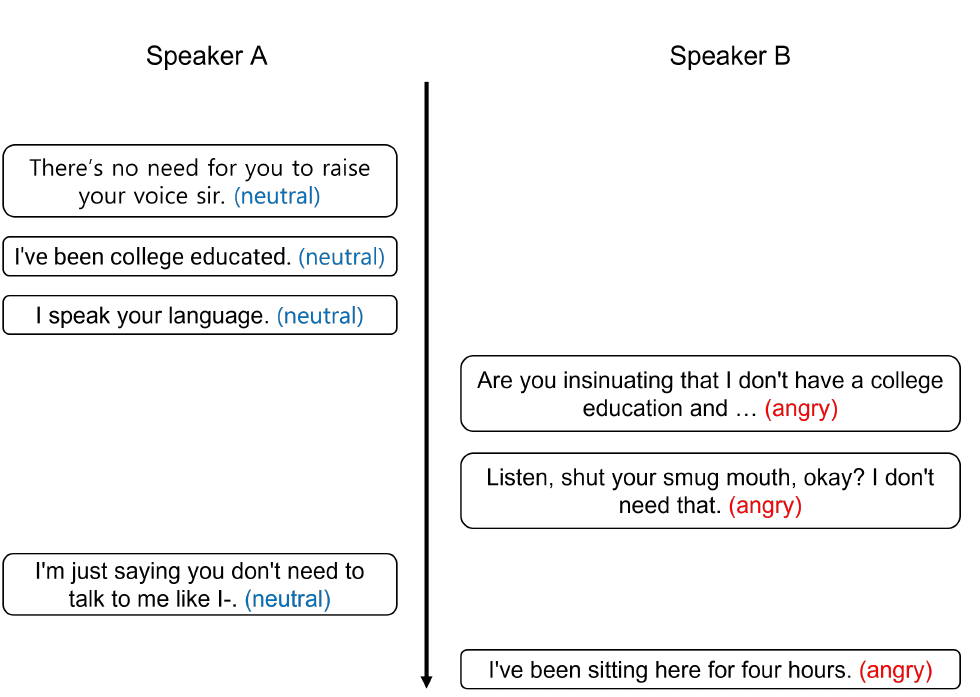
Figure 1. An example of self-dependency context. As shown in the figure, each speaker maintains a consistent emotional state regardless of the counterpart speaker’s emotional state or utterance.